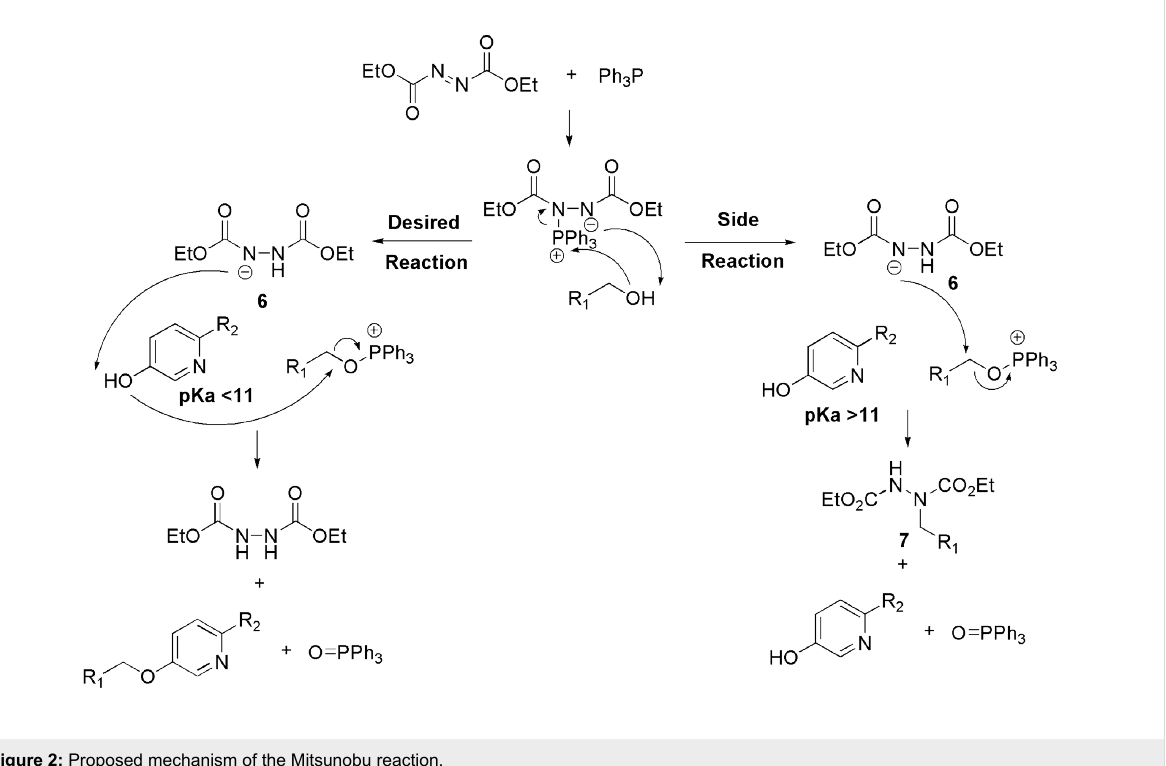
Figure 2: Proposed mechanism of the Mitsunobu reaction.